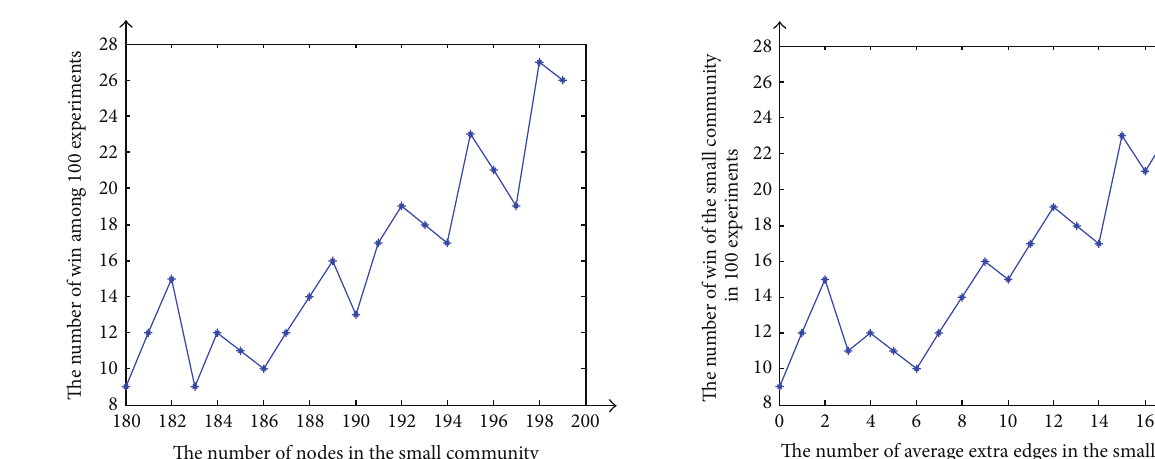
−0.8−0.6−0.4−0.2